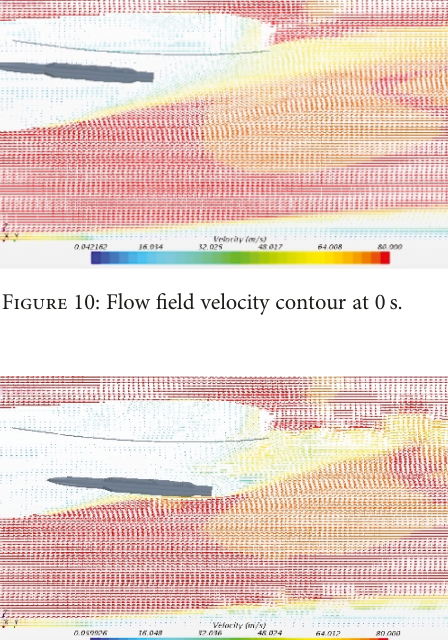
Figure 13: Flow fi eld velocity contour at 0.8s.